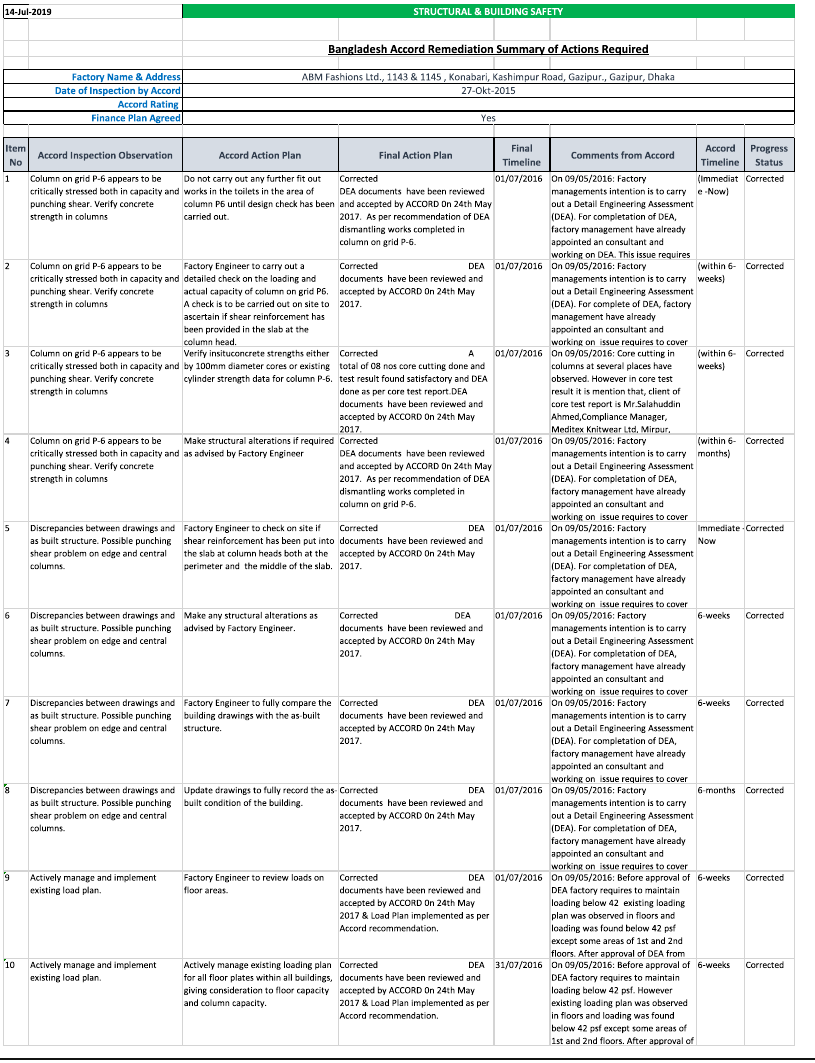
Table 2 Example of “ Corrective Action Plan ” (CAP for ABM Fashions